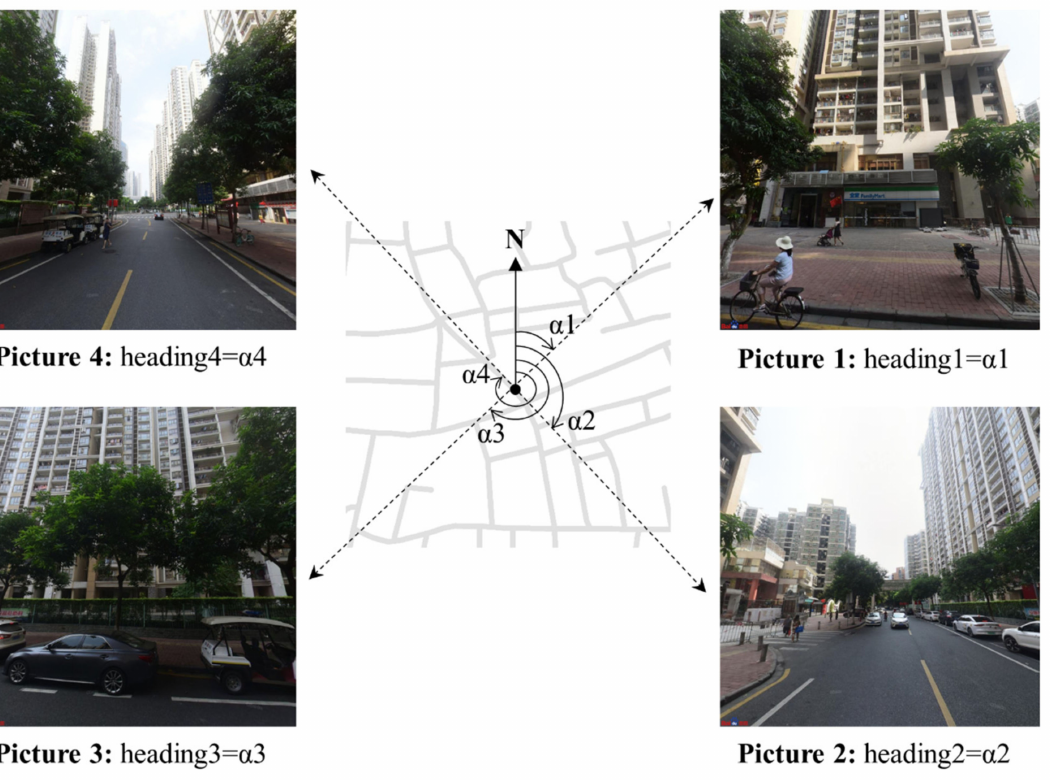
Figure 2. An example of calculating heading angles of four BSV images at a sample site. Heading angles of Pictures 2 and 4 are parallel to the street, capturing the front and rear views, while heading angles of Pictures 1 and 3 are vertical to the street, capturing the left-hand and right-hand